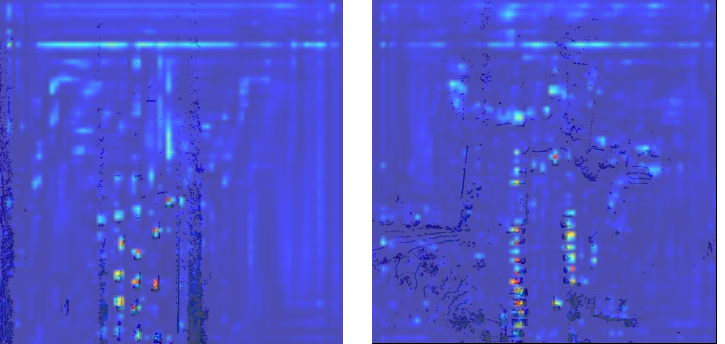
Figure 8. Original Grad-CAM adaptation results for LiDAR pointcloud with the use of our proposed class score calculation for an object detection grid tensor output. Objects (cars) are highlighted properly, but we could observe noise in generated CAM. The level of CAM detail is also low when compares to casted LiDAR detections (dark blue)